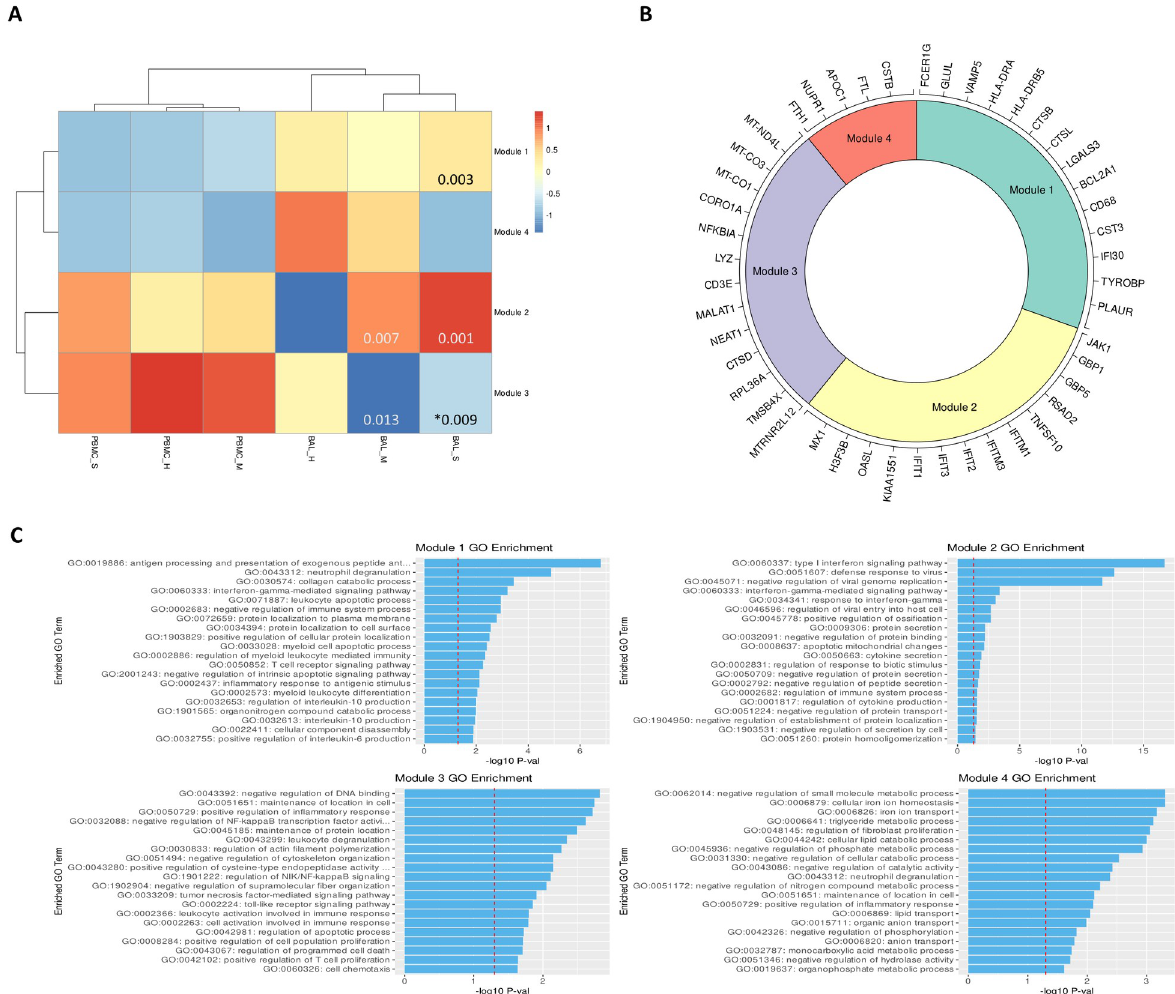
Fig 2. rDEGs grouped into four distinct modules with immune regulation enriched GO terms. A . Heatmap of modules generated from the recurrent differentially expressed genes (rDEGs). P-values are provided for comparisons with p < .05. A � indicates comparison between severe and mild cases, while all other p-values indicate comparison with controls. B . Module membership for each module. Modules 1 and 4 contain a mixture of metabolic and immune response related genes. Module 2 contains genes related to interferon activated viral defense. Module 3 contains other inflammatory regulation genes and stress response genes (generated using the Circlize R package). C . Per module GO term enrichment showing the top enriched terms for each module and their respective p-values with the red line indicating -log10(0.05). The first three modules contain inflammation related terms in their most enriched terms while module 4 only contains metabolism related